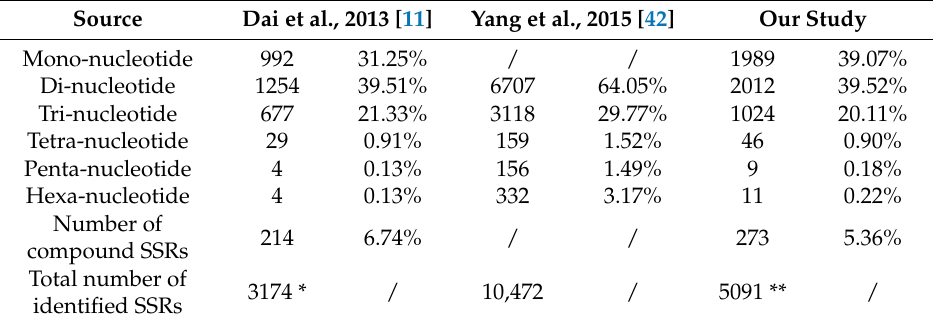
Table 4. General information of repeat type of EST-SSR motif for three hawthorn